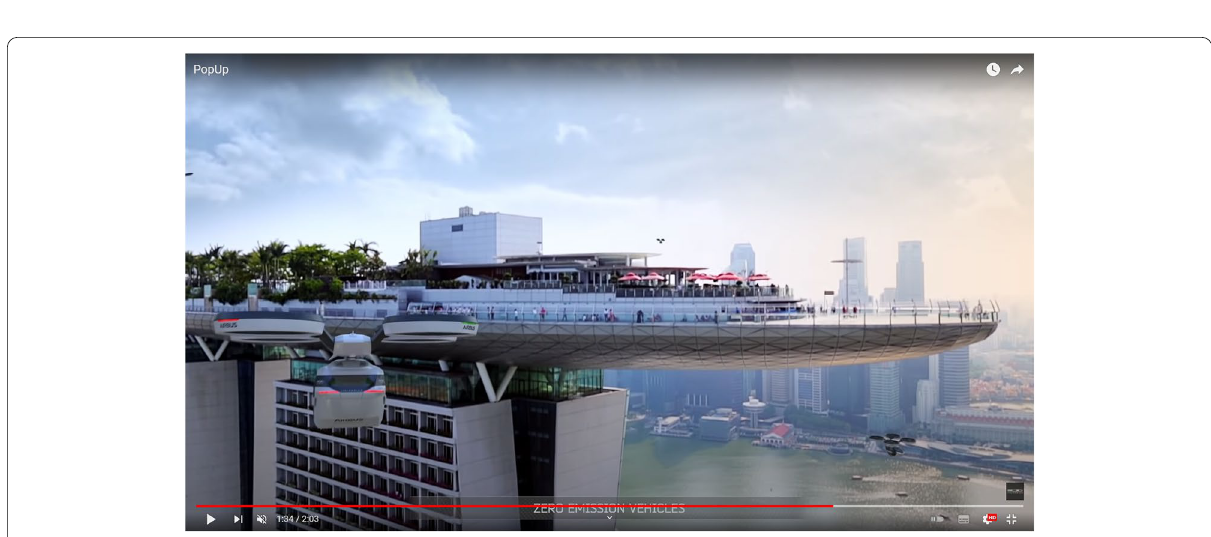
Fig. 3 Between future and fiction: Visions of future